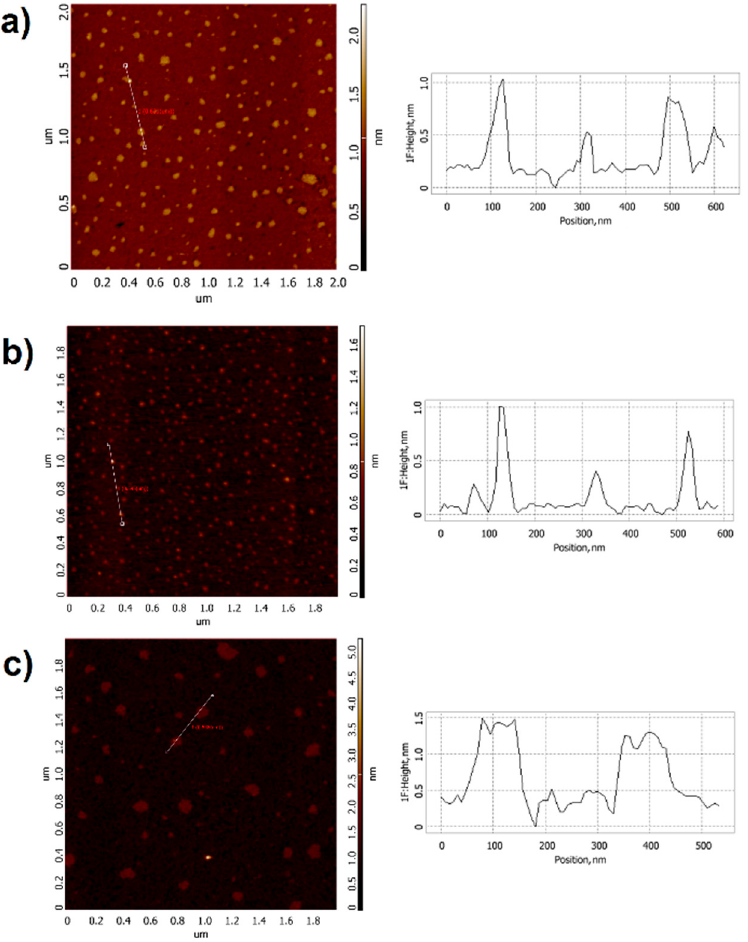
Figure 2. Typical AFM (atomic force microscopy) images of the mica substrate surface with adsorbed HRP (horseradish peroxidase) macromolecules and cross-sections, corresponding to the lines in the AFM images, obtained in control experiments ( a ), and when the HRP solution was incubated near either inflow ( b ) or outflow ( c ) sections of the pipe.